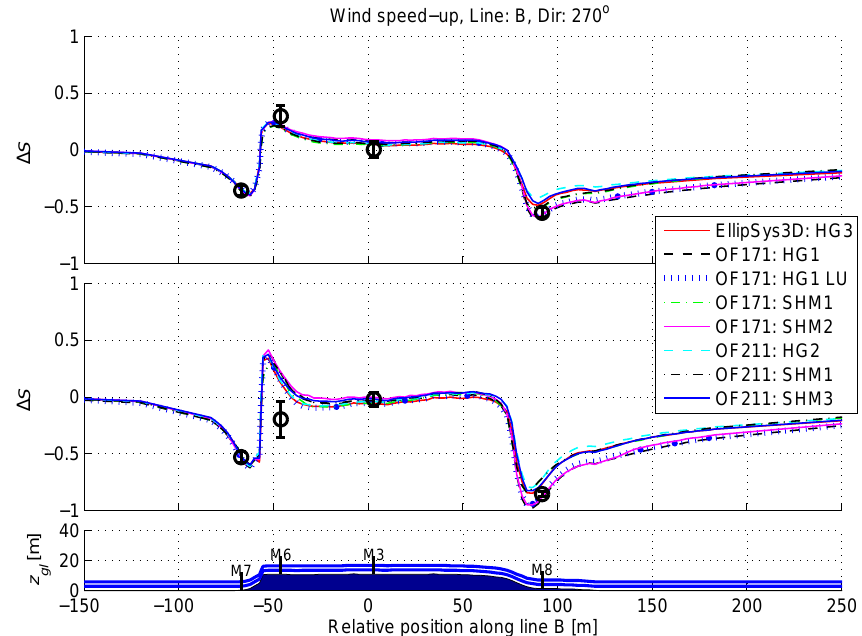
Figure 9. Bolund Hill: speedup along line B. Uppermost panel: 5ma.g.l. (above ground level); middle panel: 2ma.g.l. Measurements are denoted as circles with corresponding uncertainties denoted by an error